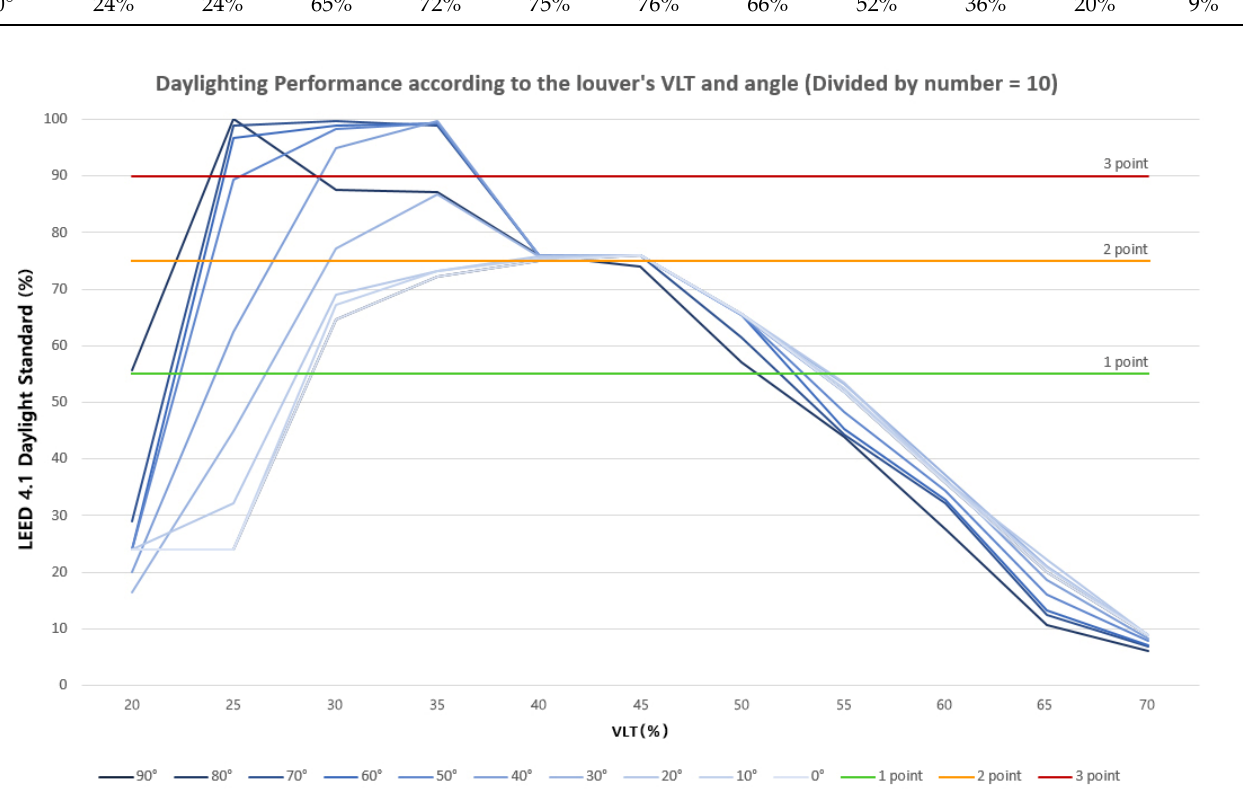
Figure 5. Target illuminance achievement rate graph when the number of divisions of louvers is 10.